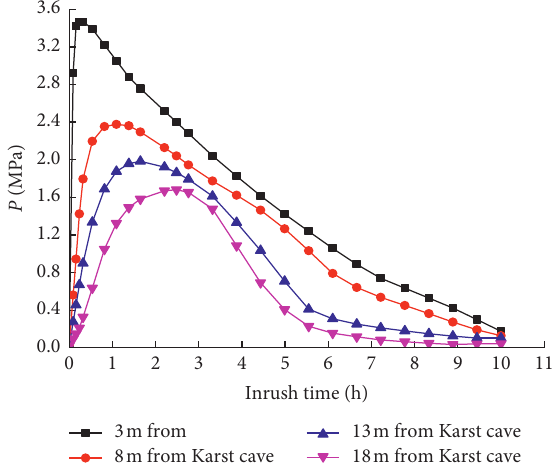
Figure 16: The evolution law of water pressure on roadway transverse sections which are 3m, 8m, 13m, and 18m away from karst cave.